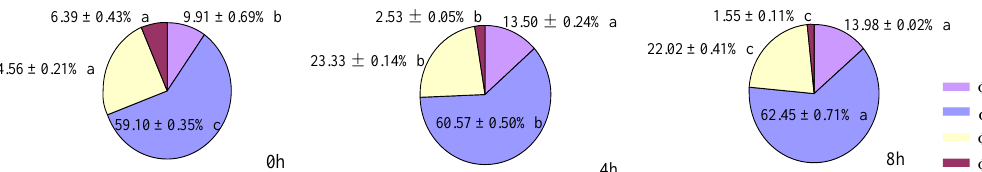
Figure 4. Light energy used for quantum yield of PSII photochemistry ( Φ PSII ), xanthophyll-mediated thermal dissipation ( Φ NPQ ), basic fluorescence quantum yield and heat dissipation quantum yield ( Φ f,D ), and quantum yield used in thermal dissipation in non-functional PSII ( Φ NF ) in leaves of mulberry seedlings exposure to 4 µ L · L − 1 NO 2 for 0 h, 4 h (4 h · d − 1 , for one day), and 8 h (4 h · d − 1 ,